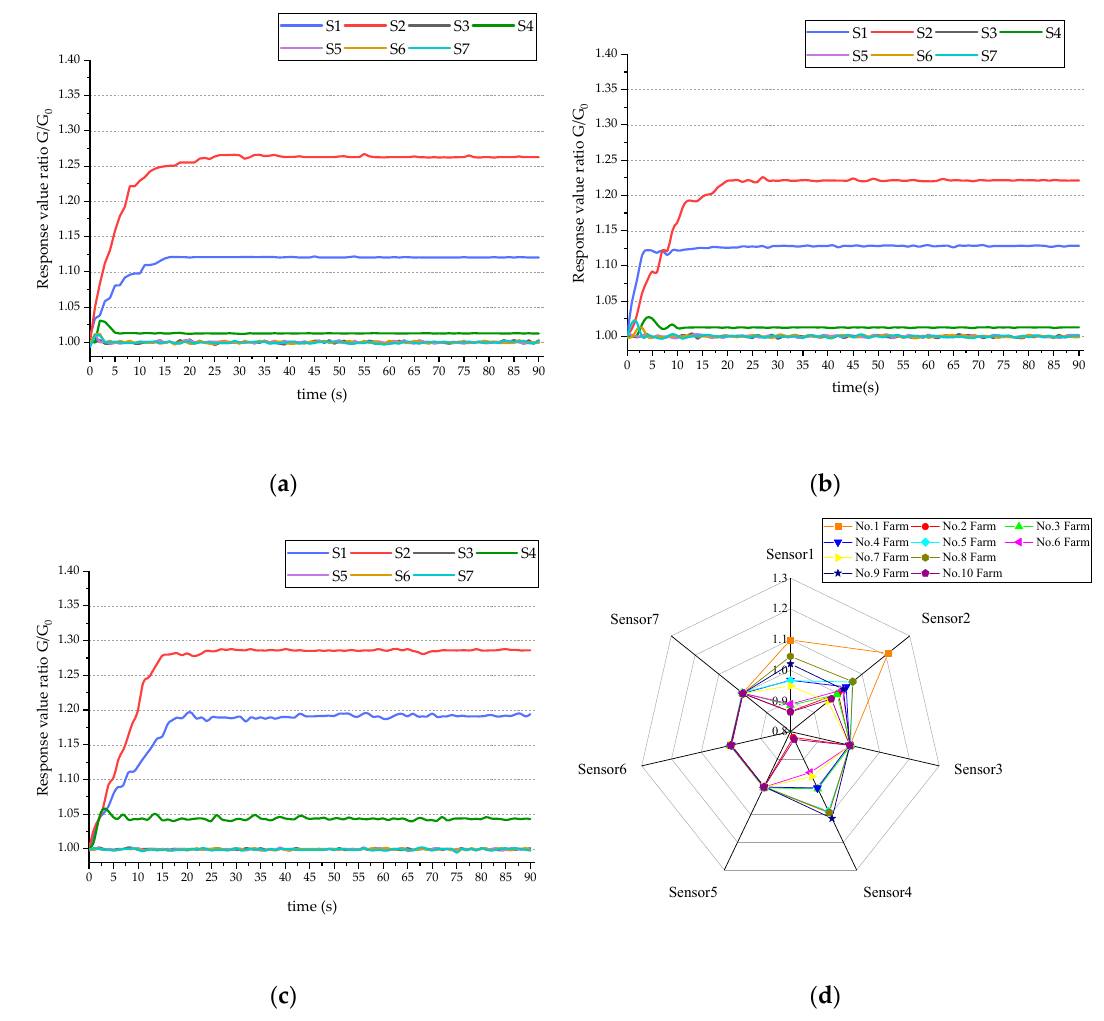
Figure 3. Response curve and radar chart for E-nose data: ( a – c ) response curve of E-nose; ( d ) radar chart of E-nose.